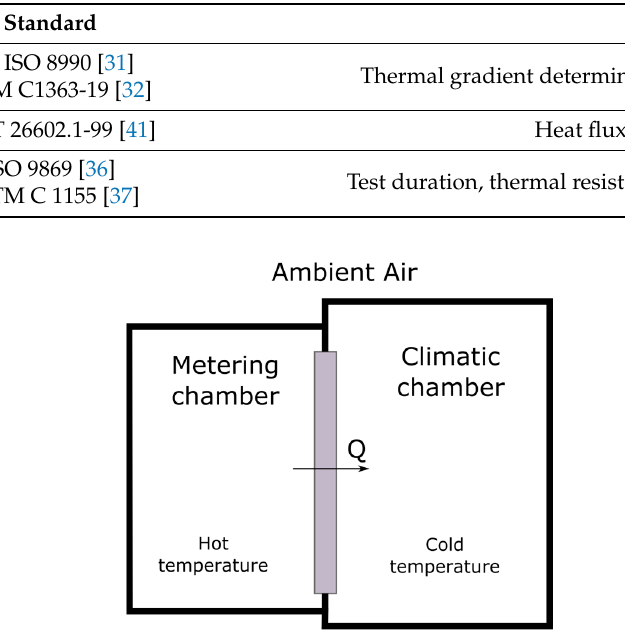
Table 1. List of standards and their significance for the study.